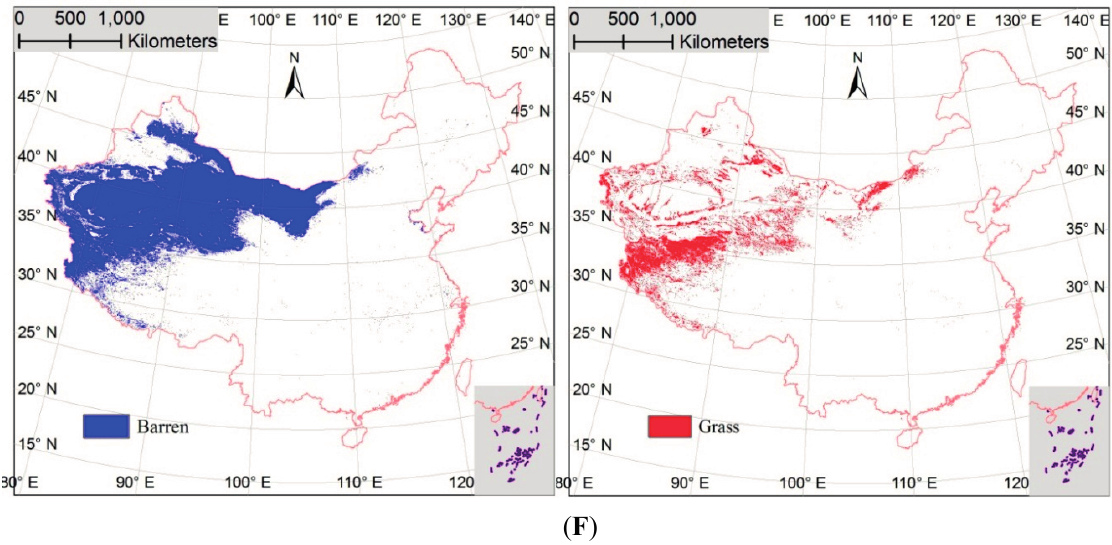
Figure 6. Distribution of the six land cover types in the aggregated classification and the distribution of the main misclassified classes that correspond to land cover types. ( left ) The picture for each land-cover type shows the distribution of the aggregated class in the classification map; ( right ) the picture represents the distribution of the primary misclassified class that corresponds to that class. ( A ) Distribution of croplands and the primary classes that were misclassified as croplands. ( B ) Distribution of shrublands and the primary classes that were misclassified as shrublands. ( C ) Distribution of forests and the primary classes that were misclassified as forests. ( D ) Distribution of grasslands and the primary classes that were misclassified as grasslands. ( E ) Distribution of urban and built-up lands and the primary classes that were misclassified as urban and built-up lands. ( F ) Distribution of barren lands and the primary classes that are misclassified as barren lands.